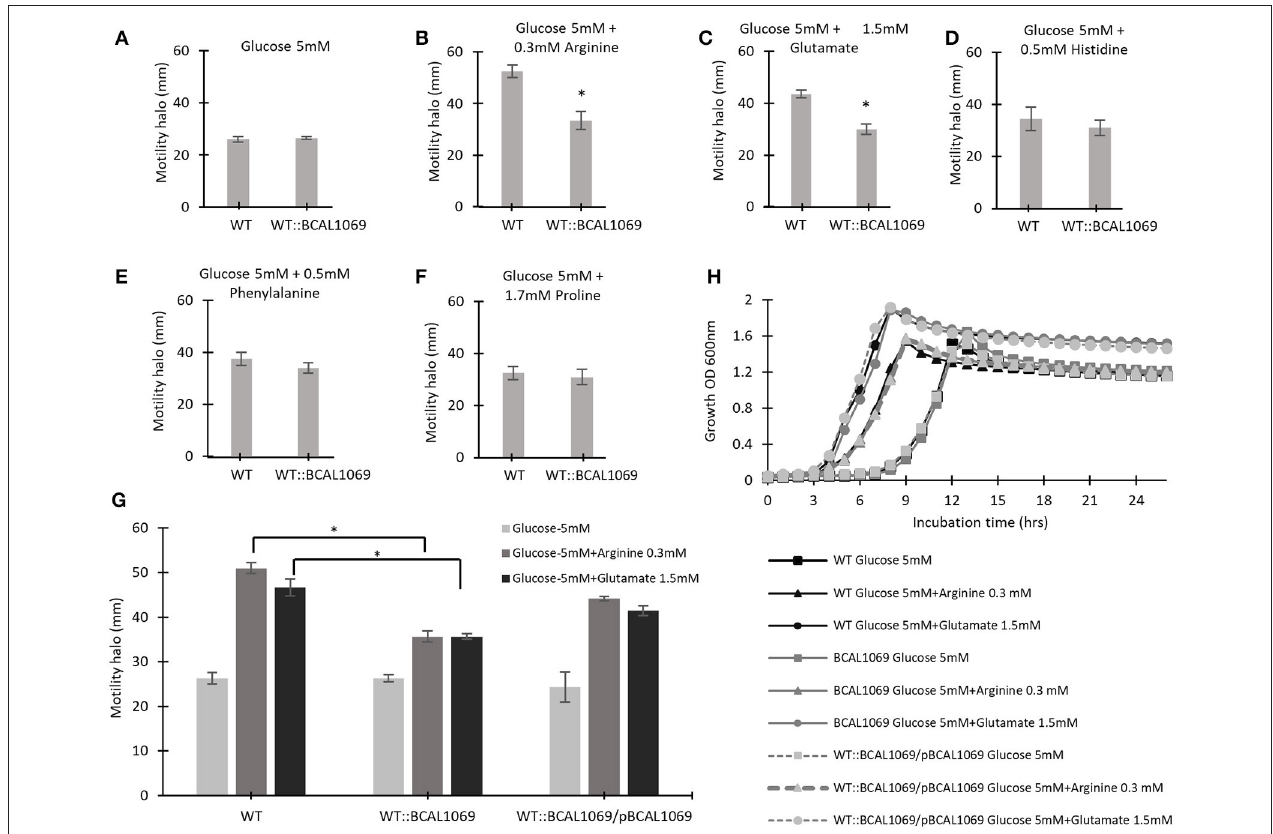
FIGURE 5 | The effect of individual amino acids on the swimming motility of WT and WT::BCAL1069 mutant. (A–G) The motility halos of the indicated strains were examined in MOPS-glucose 5mM with individual amino acids at the same concentration as present in SCFM, after incubation for 24h at 37 ◦ C. Each experiment was performed three times independently in duplicate (* p < 0.01). (H) Growth curves of WT, WT::BCAL1069 and WT::BCAL1069/pBCAL1069 in MOPS-glucose 5mM with individual amino acid at the same concentration as present in SCFM. The figure is representative of one from two independent experiments.